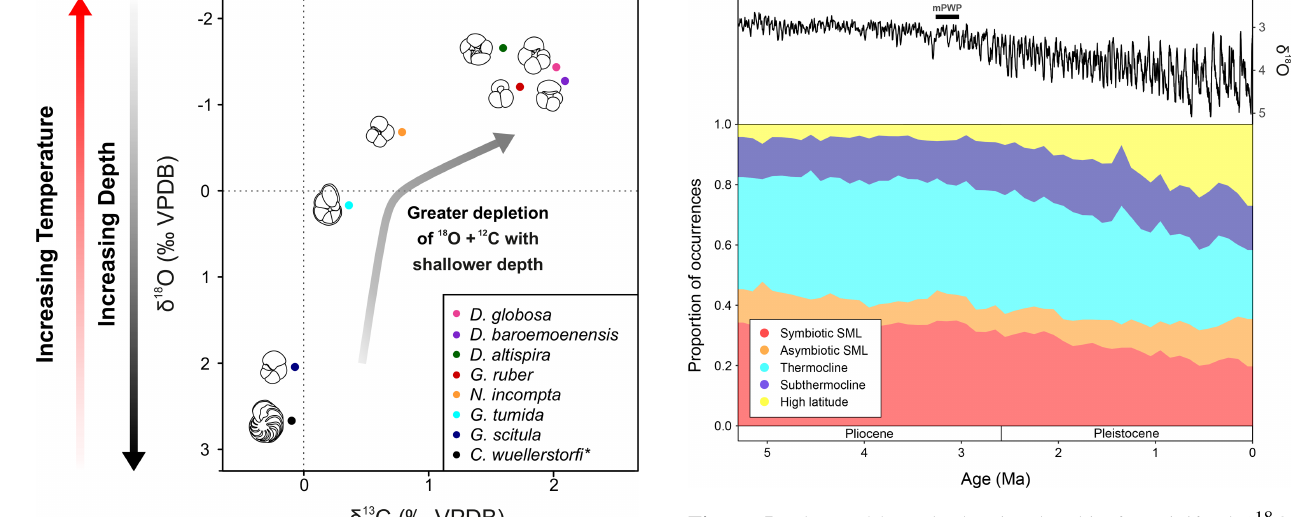
and Shackleton, 1995), or lower mixed layer/upper thermo- cline (Zou et al., 2022) ecological niche habit.